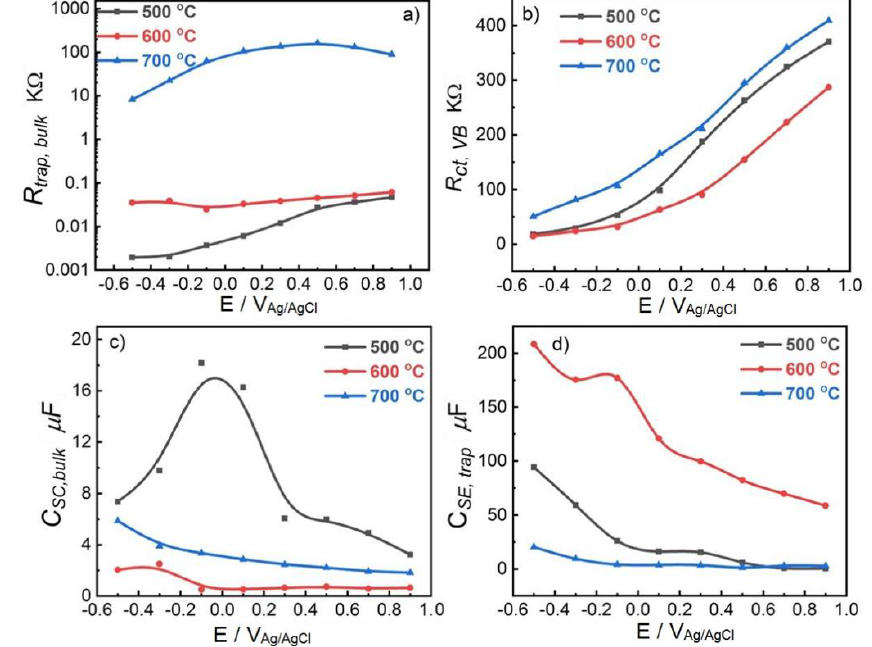
Figure 9. Electrical circuit parameters retrieved from the EIS measurements performed in 1 M NaOH and equivalent circuit fitting. ( a ) Bulk transport resistance ( R trap,bulk ) represents the bulk recombination resistance and the trend suggests the increase in the electron – hole recombination with a change in the phase ratio of anatase to rutile, which is in agreement with the IMVS measurements. ( b ) Charge transfer resistance ( R ct,VB ) indicates the resistance of the hole transfer from the valence band of the semiconductor to the electrolyte, which is in agreement with the charge transfer efficiency and the photocurrent trend observed for the TiO 2 nanotubes. ( c ) C SC, bulk is the space charge layer capacitance. The trend suggests an improved charge separation in TNT500 and a decrease in charge separation in mixed-phase TiO 2 . It is in agreement with R trap, bulk . ( d ) C SE, trap suggests the hole transfer ability to the electrolyte. It is in agreement with the trend observed in the photocurrent.